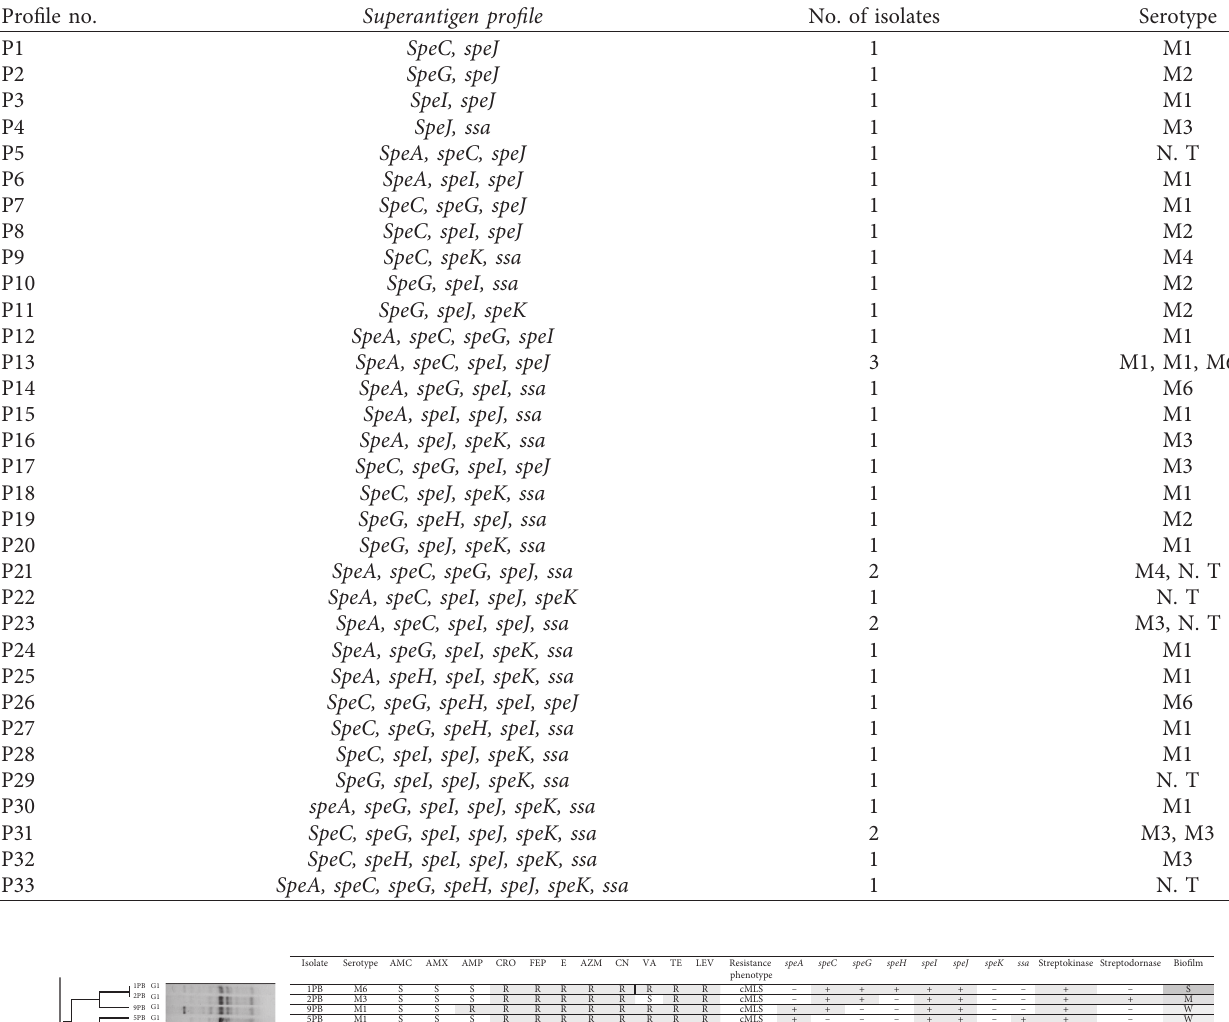
Table 2: SAgs gene profiles in different S. pyogenes isolates.